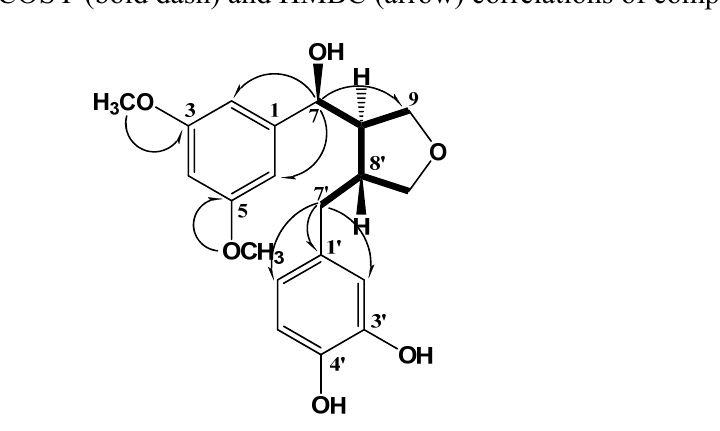
Table 1. 1 H- (400 MHz) and 13 C-NMR (100 MHz) data of compound 1 (in CD ppm, J in Hz) a .